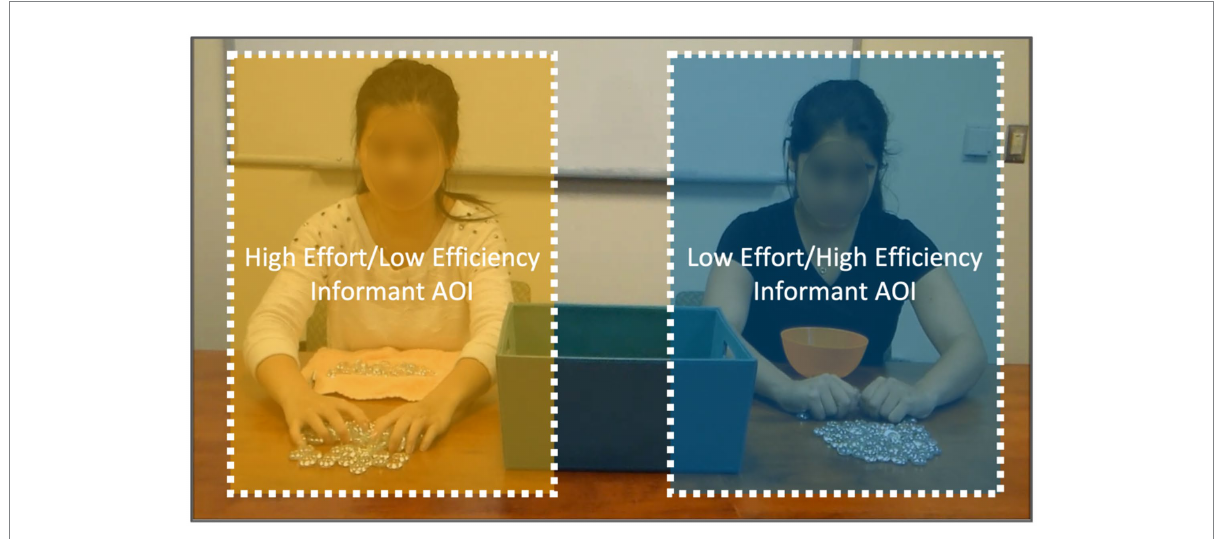
FIGURE 2 Example areas of interest (AOIs) during the testing